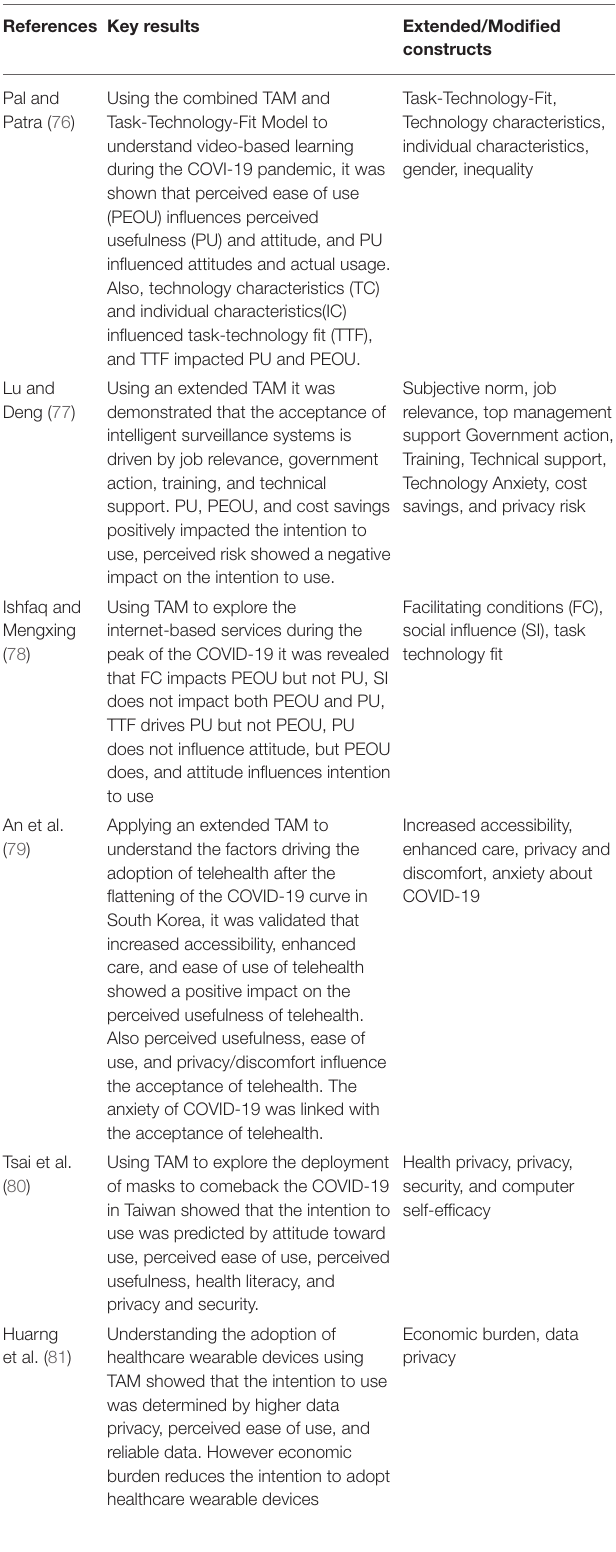
TABLE 3 | TAM’s recent application